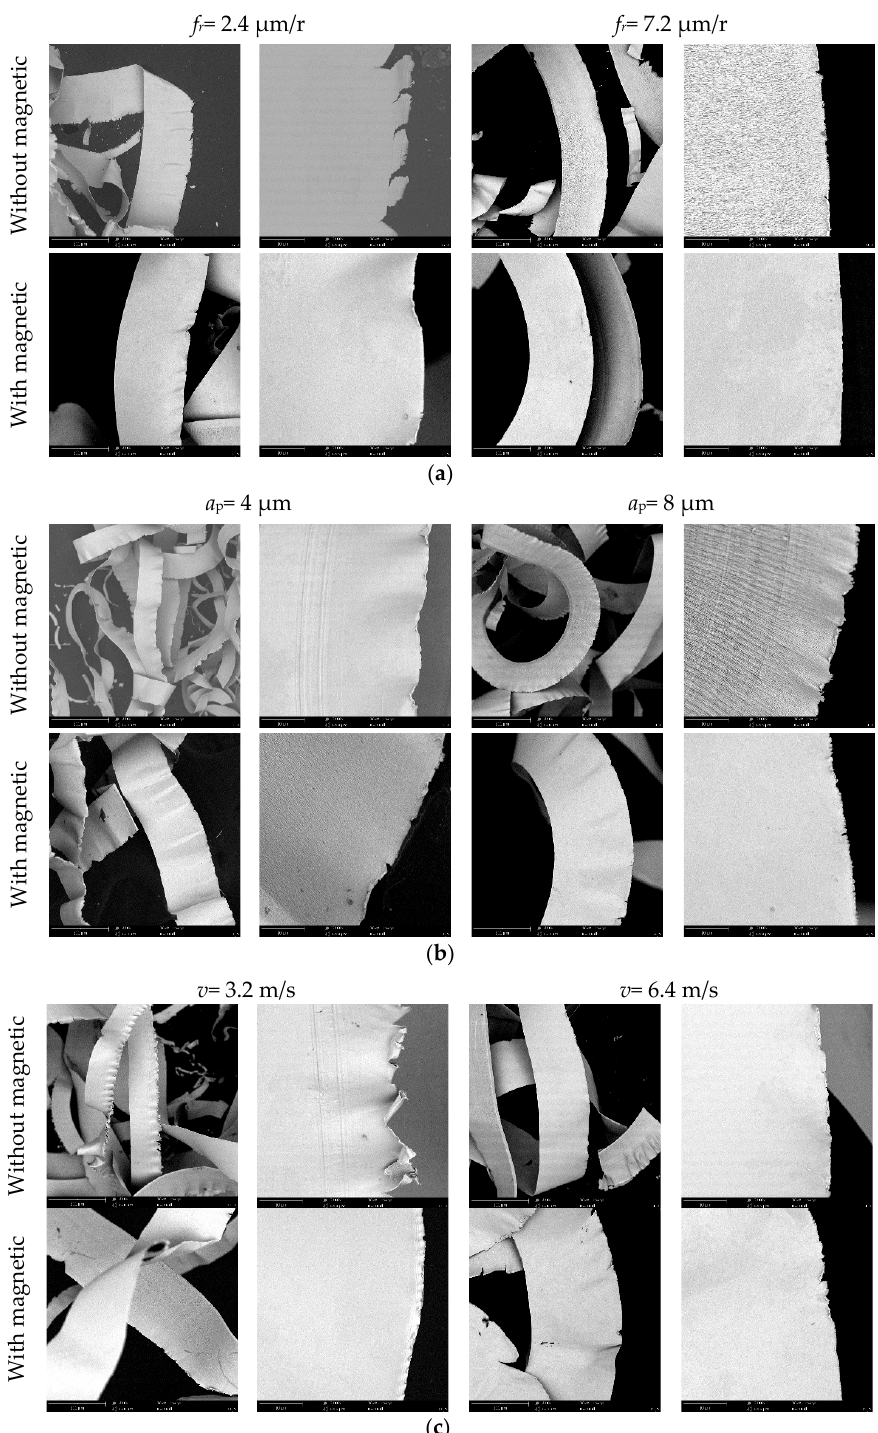
Figure 10. Effect of magnetic-field-assisted turning on chip morphology, ( a ) chip morphology var- ying with feed rate, ( b ) chip morphology varying with depth of cut, ( c ) chip morphology varying with cutting speed.